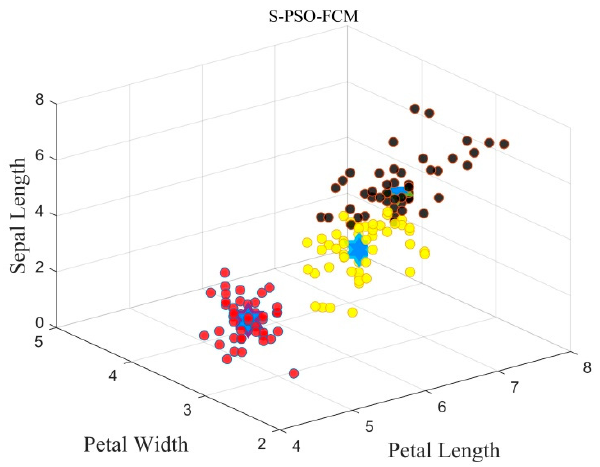
Figure 3. Standard dataset results from S-PSO-FCM. (The black solid dot denotes the Iris-verginica. The red solid dot denotes the Iris-setosa, and the yellow solid dot denotes the Iris-versicolor.) Table 2. Clustering results.